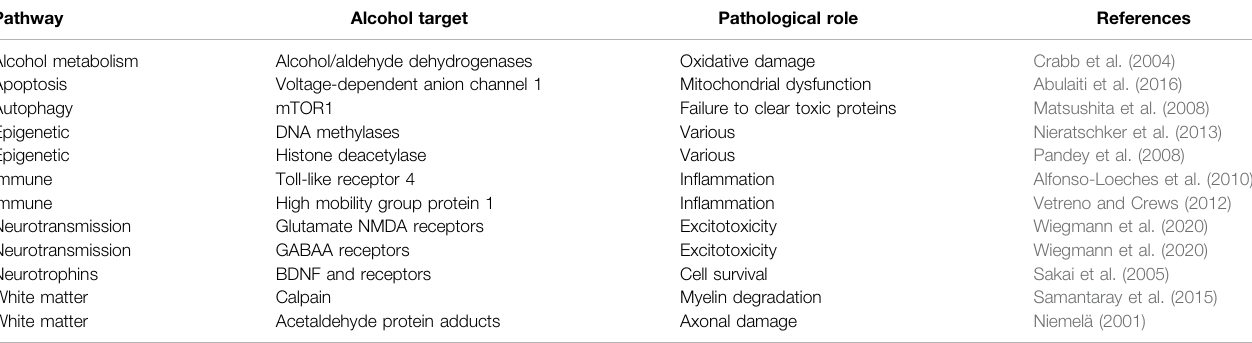
Table-speci fi c references Sakai et al. (2005) and Crabb et al. (2004).